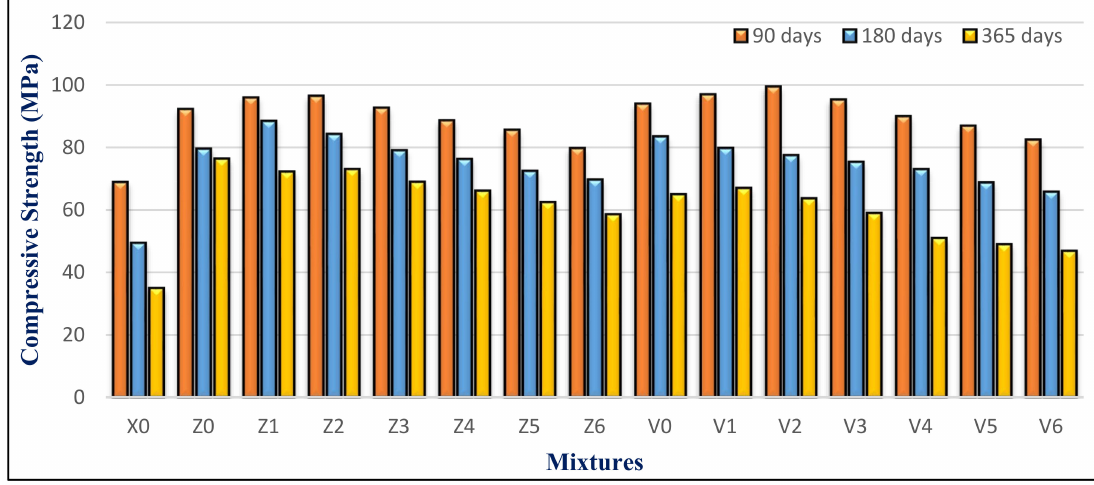
Figure 27. Group Z and V strength results after sulfate